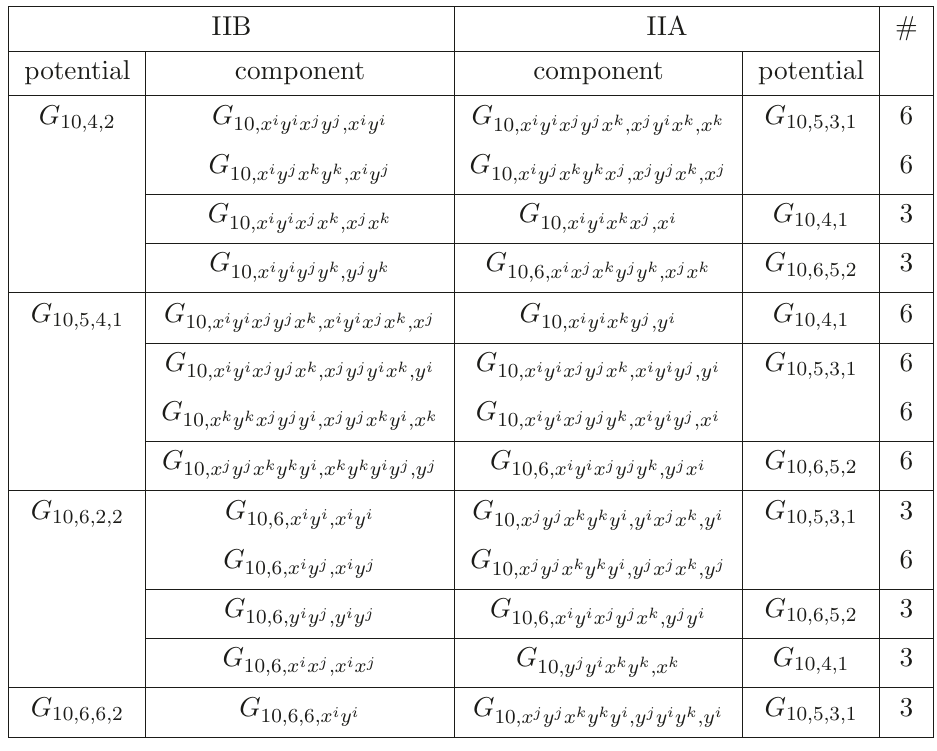
Table 5 . The α = − 5 branes that can be included in order to cancel the tadpoles generated always by the NS ′ and RR ′ fluxes. To avoid cumbersome notations, in all terms we have not specified the sets of ten and six internal indices. Moreover, the indices i , j , k are always understood to be different. In the last column we give the number of independent components for each potential, which corresponds to the number of different branes, which are 60 in